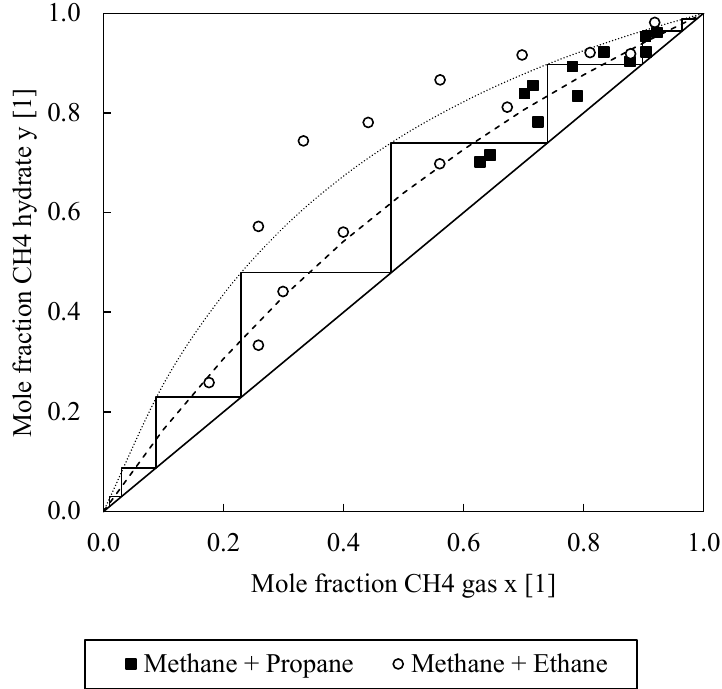
Figure 3. Adapted McCabe-Thiele trends in a chart where the mole fraction of methane in the hydrate phase (ordinate) is plotted against the mole fraction of methane in the gas phase (abscissa); dotted curve: equilibrium curve of the methane-ethane system; dashed curve: equilibrium curve of the methane-propane system; exemplary step-draw method pictures the necessary number of process stages for the gas separation in the methane-ethane system (8 stages). The methane-propane system is analogous but more separation stages are necessary (17 stages) and, for reasons of clarity, not shown in the